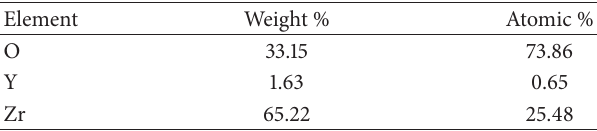
Table 2: EDX of 3YSZ